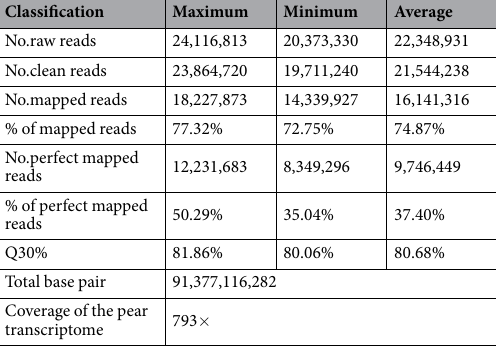
Table 1. Statistics on the quality and output of the RNA-Seq